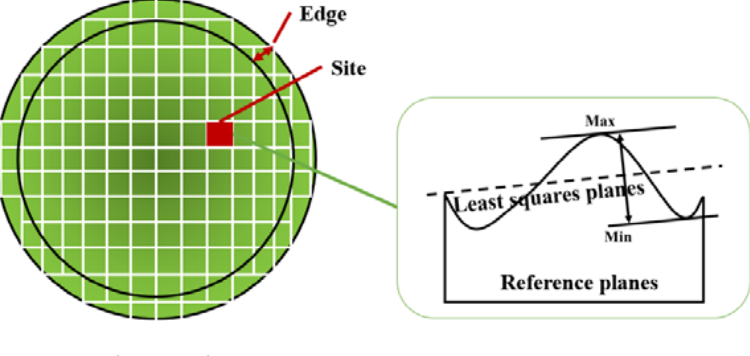
Figure 6. Definition of ESFQR